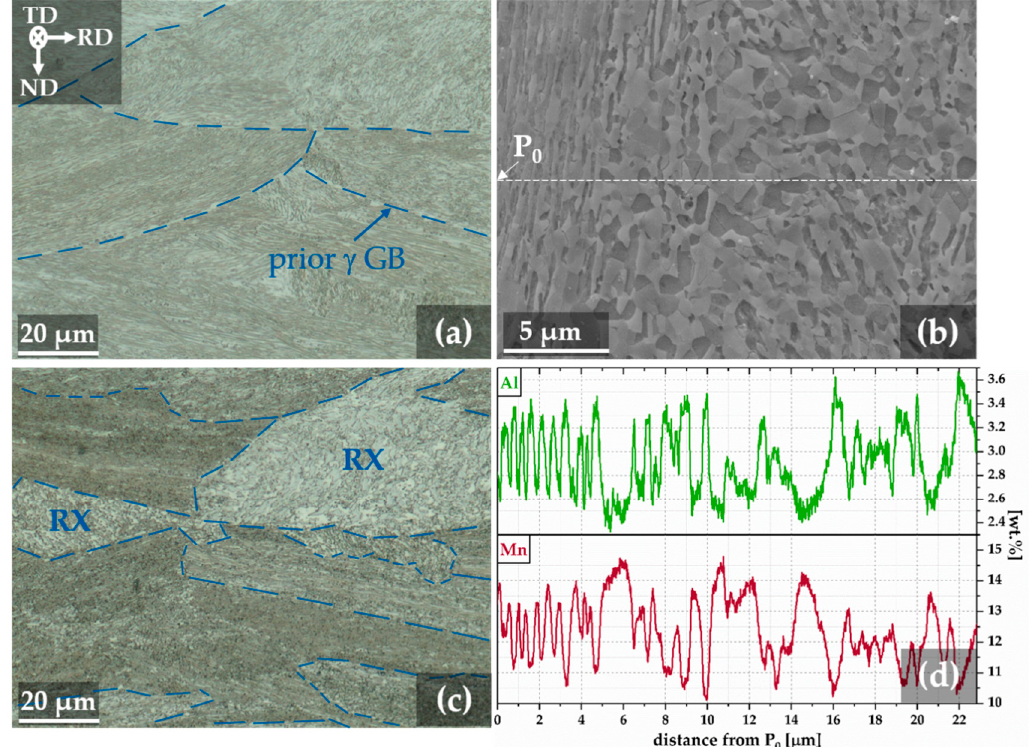
Figure 2. ( a , c ) Optical micrographs of the X6MnAl12-3 MMnS ( a ) after 50% cold rolling and ( c ) after intercritical annealing. Easily identifiable prior γ grain boundaries in ( a ) and grain boundaries of recrystallized grains in ( c ) are highlighted in blue. ( b ) Secondary electron (SE) image of the microstructure after intercritical annealing, and ( d ) the corresponding Energy Dispersive X-ray Spectroscopy (EDS) analysis of the local Al and Mn contents are shown.